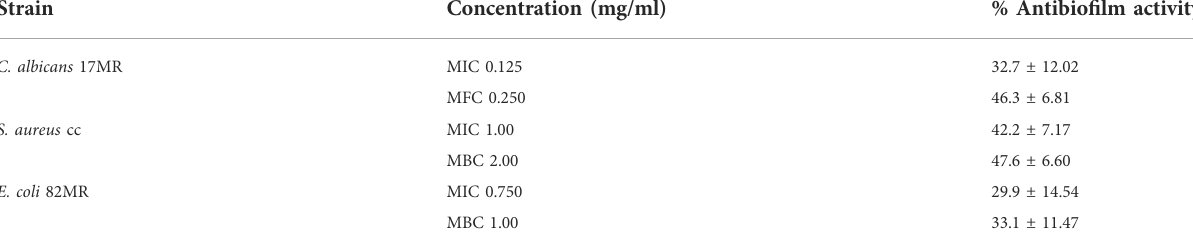
TABLE 3 Antibio fi lm activity of the essential oil of A. porophyllum var. cancellatum .